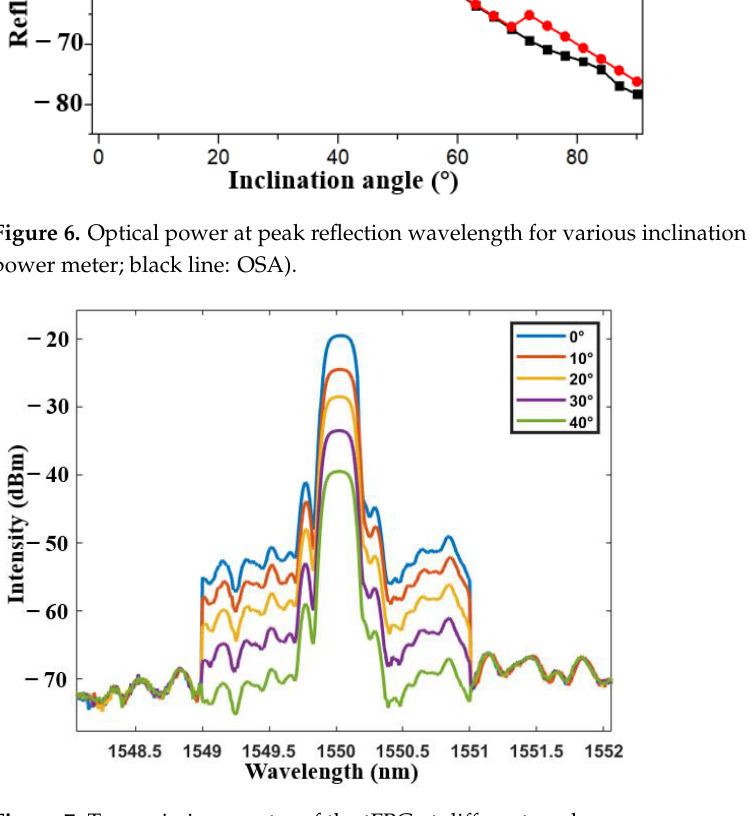
Figure 7. Transmission spectra of the tFBG at different angles.